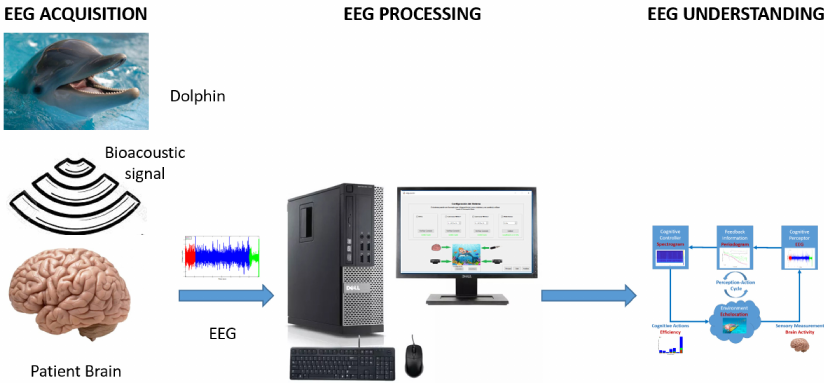
Figure 6. Healthcare Smart System (HSS) for measuring dolphin-assisted therapy